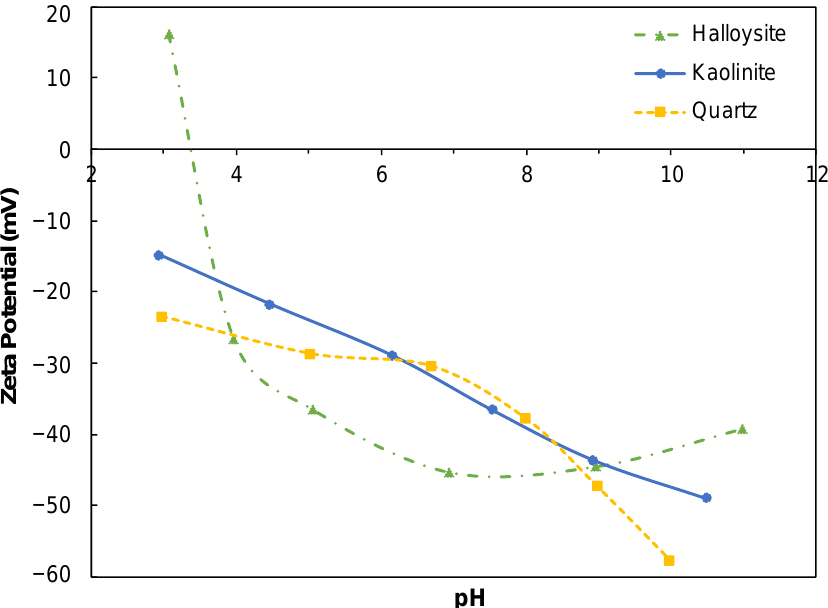
Figure 5. Zeta potential of halloysite, kaolinite, and quartz minerals as a function of pH. The zeta potential values of kaolinite and quartz minerals were negative in all mea- surements and were increasingly negative from pH 3 to 11 (Figure 5). As seen from the zeta potential-pH graph, the zero point of charge (ZPC) of the halloysite mineral was approximately pH 3.5. The zeta potential of halloysite mineral was measured as − 8.29 mV at natural pH (3.8). The surface charge of the sample was positive at acidic pH values lower than pH 3.5 and increased to 16.22 mV at pH 3. For the halloysite, the surface charge of the sample decreased to − 45.25 mV from ZPC to pH 7, and it was measured as − 39.15 mV for pH